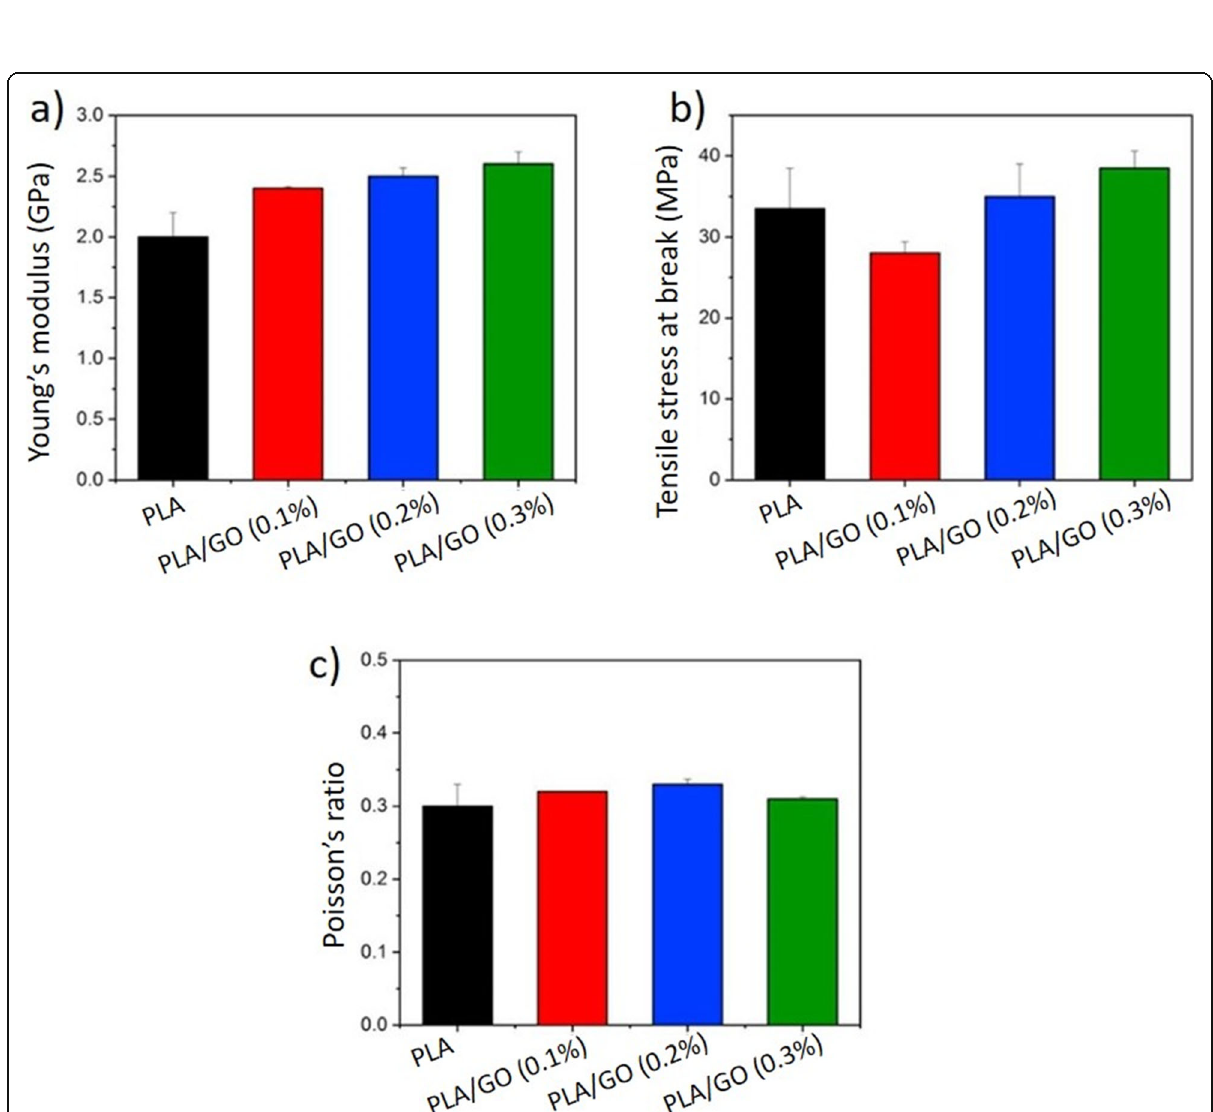
Fig. 7 Mechanical properties of PLA and PLA/GO scaffolds produced by FDM: a Young ’ s modulus, b Tensile stress at break, and c Poisson ’ s ratio. Reproduced with permission from